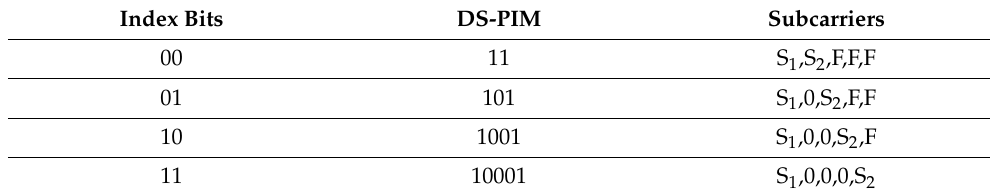
Table 4. Subcarrier selection for a 2-bit index data word on B1, using the proposed scheme.